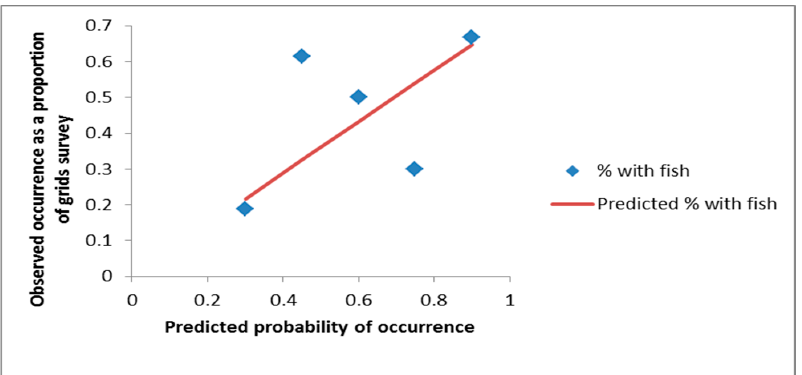
Figure 3. Calibration plot of logistic regression model of fish presence for bullhead (first class 0.3 with 0.15 intervals); y = 0.8556x, R 2 = 0.90, p < 0.01.